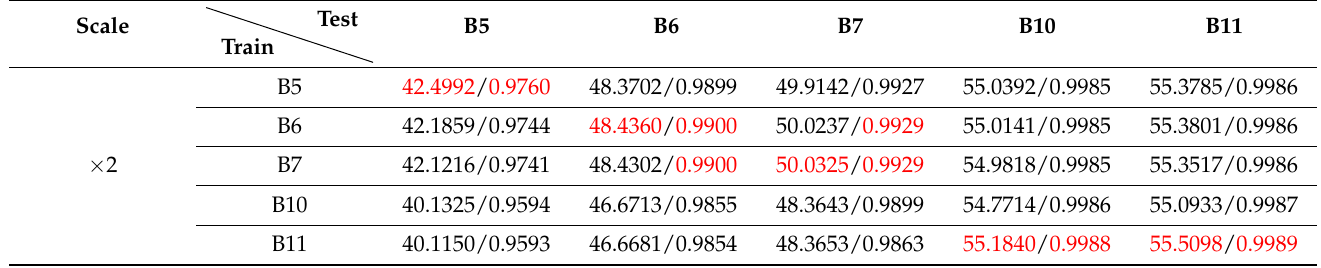
Table 10. Results of spectrum adaptability for unsupervised learning (PSNR(dB)/SSIM). The best results of every spectrum are marked in